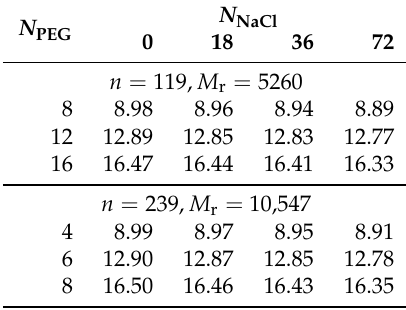
Table 4. Molalities of sodium chloride (mol/kg) in production runs of all the simulated systems. N